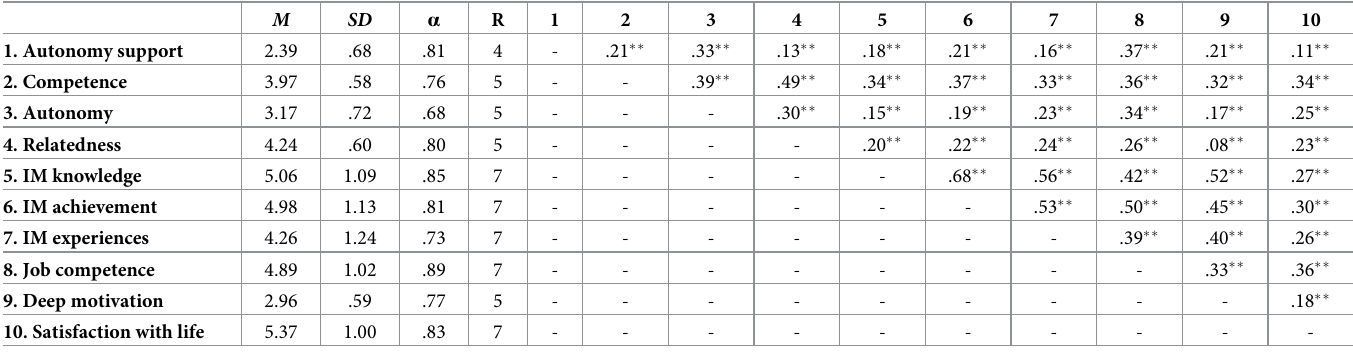
Table 1. Mean, standard deviation, and correlations between